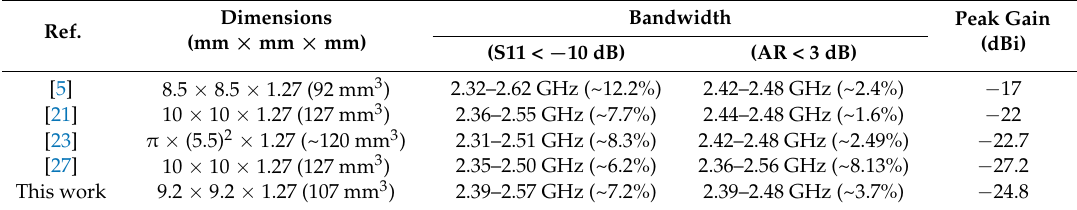
Table 3. Comparison of the proposed antenna with prior